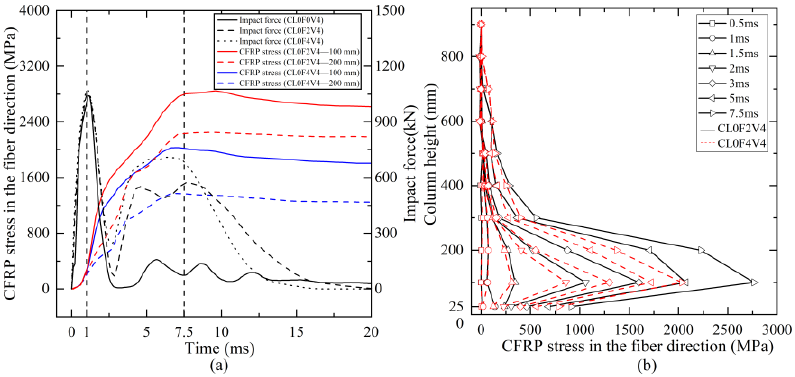
Figure 15. Response curves of CFRP stress: ( a ) time histories at different heights; ( b ) distribution along the column height.